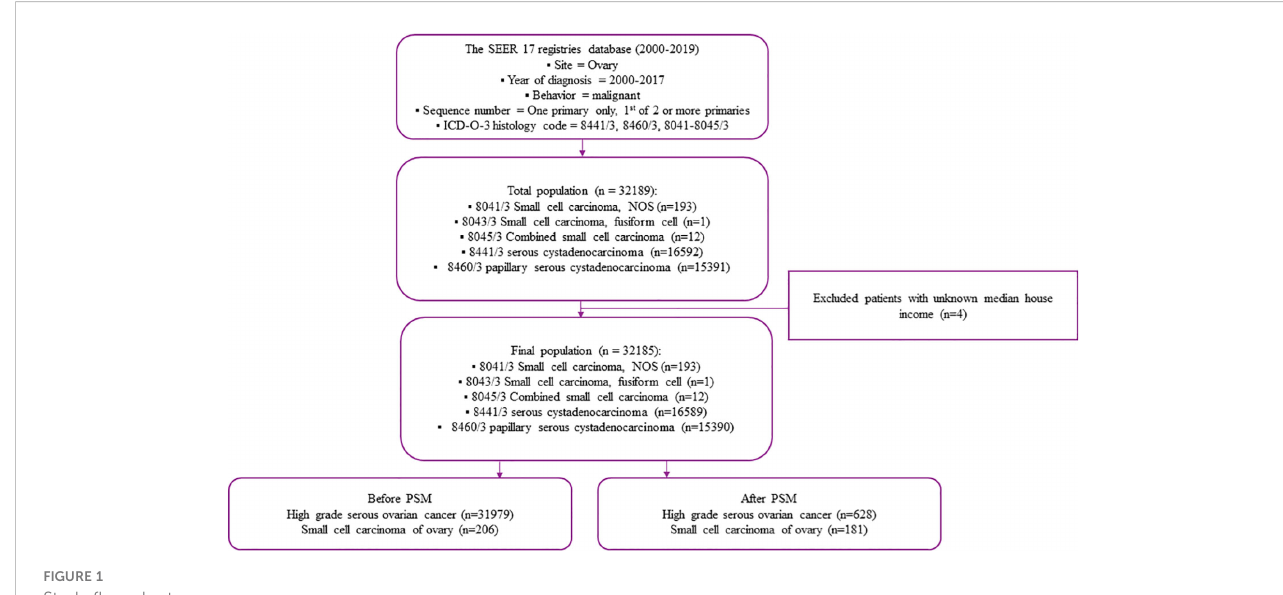
FIGURE 1 Study fl ow